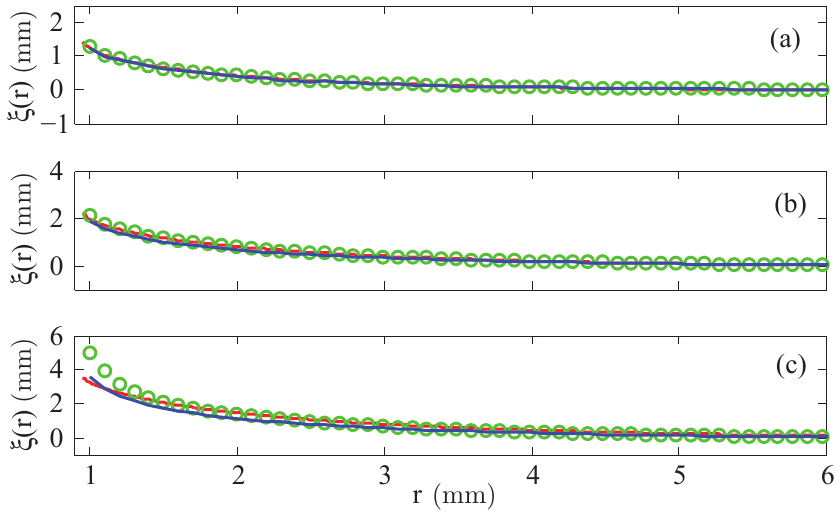
Figure 4. Calculated menisci of the magnetic fluid EMG 909 for a linear law of magnetisation with χ = 0.61 ( ) and χ = 0.8 ( ◦ ) versus the experimentally determined surfaces ( ). ( a ) H = 3.35 kA/m, ( b ) H = 7.54 kA/m , and ( c ) H = 11.73 kA/m at R = 0.95